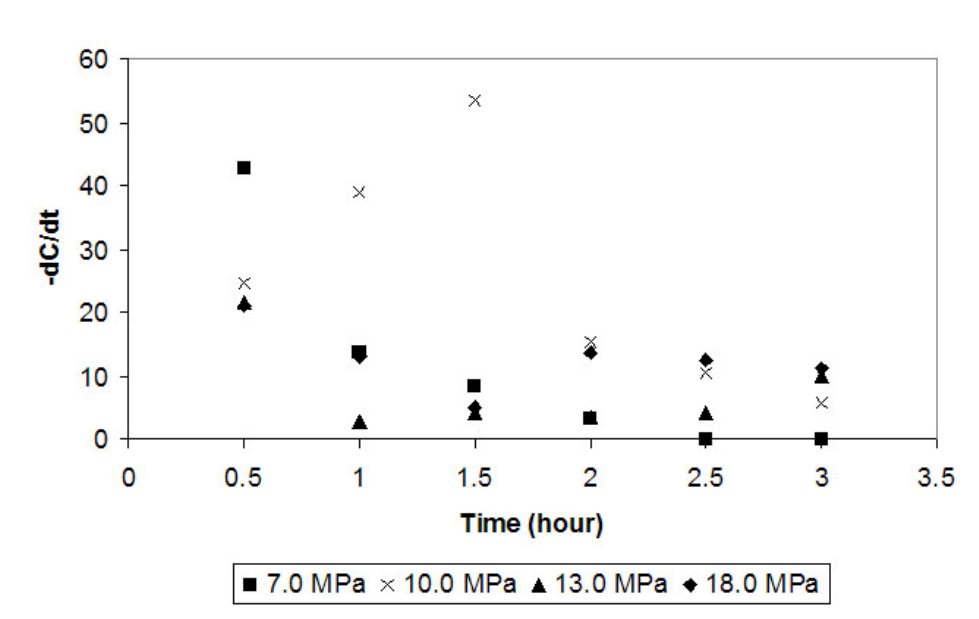
Figure 2. Phenol instantaneous consumption rate by tyrosinase in different